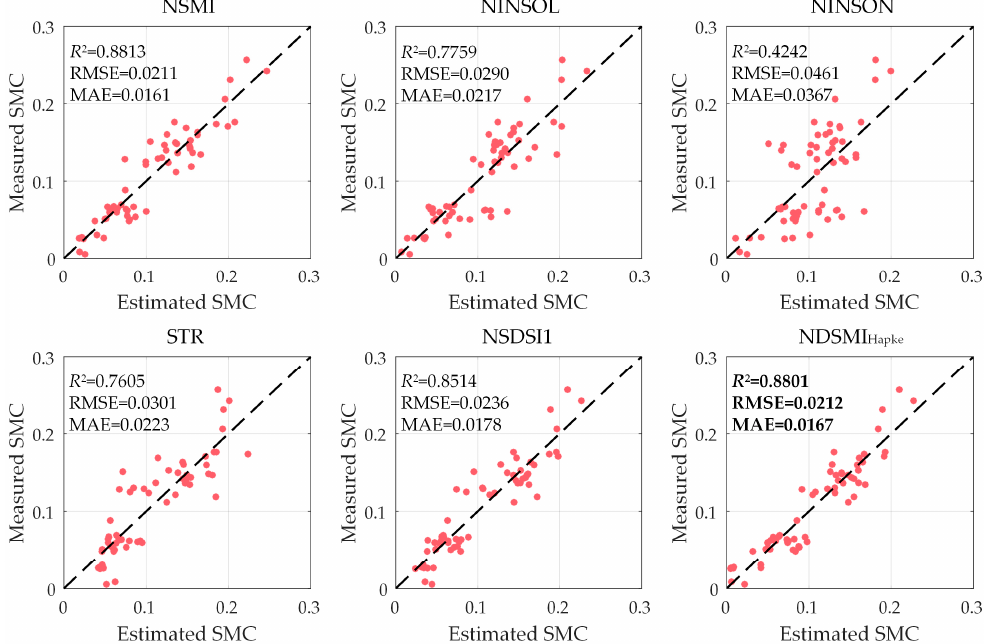
Figure 16. Estimated and measured SMC for the six soil moisture indices on the verification set.